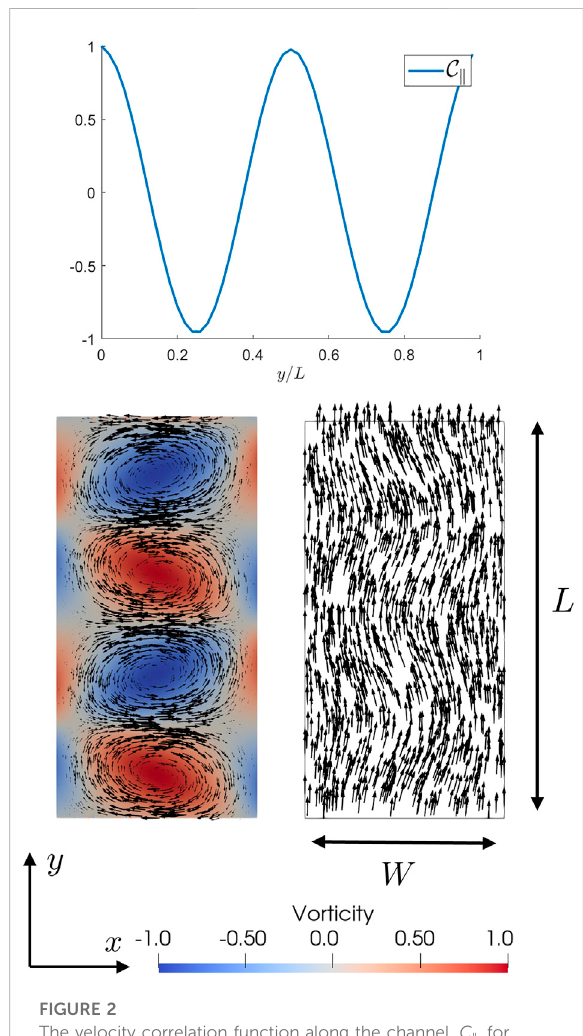
FIGURE 2 The velocity correlation function along the channel, C (cid:4) , for the vortex lattice state ( ℓ η = 0.30, α = − 2.00) with strong anchoring ( ℓ κ = 0.01). The fl ow pro fi le v (bottom left) and polarization p (bottom right) in the vortex lattice state are plotted at the